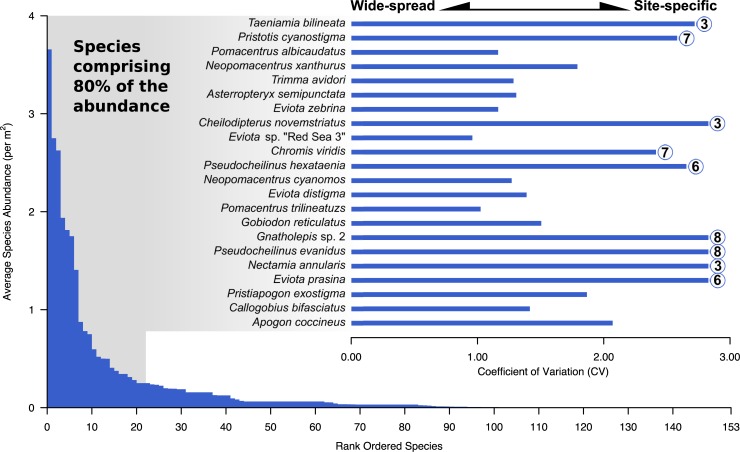
Rank ordered species abundance per transect.CV is shown for species comprising 80% of the total abundance in Al Wajh Bank. Survey site most associated with nine highly localized species are shown.